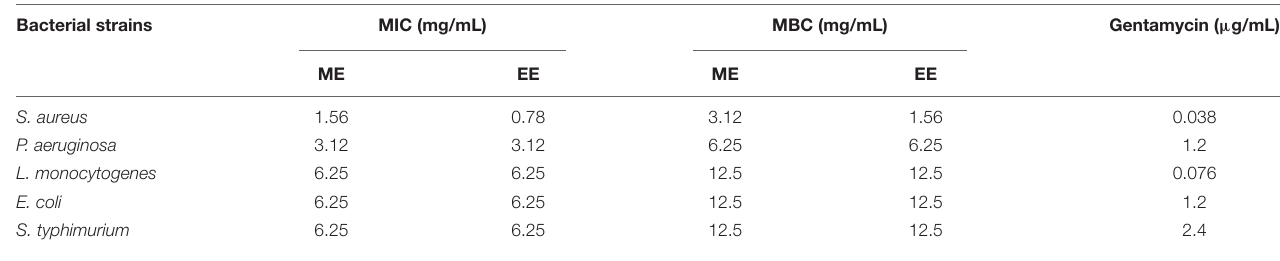
TABLE 7 | Antibacterial activity of A. laxmannii extracts (MIC, MBC). Bacterial